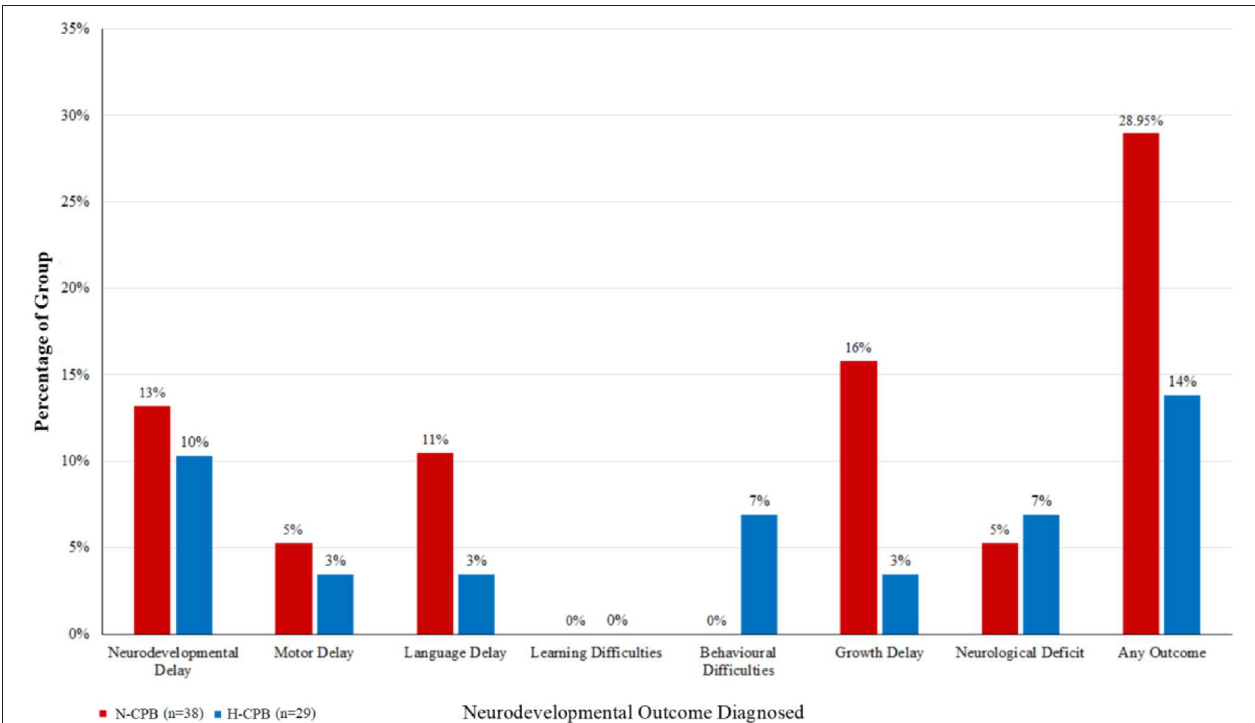
FIGURE 2 | The percentages of each group diagnosed with an adverse neurodevelopmental outcome a few years after surgery, excluding the cohort of patients who have been diagnosed with a genetic